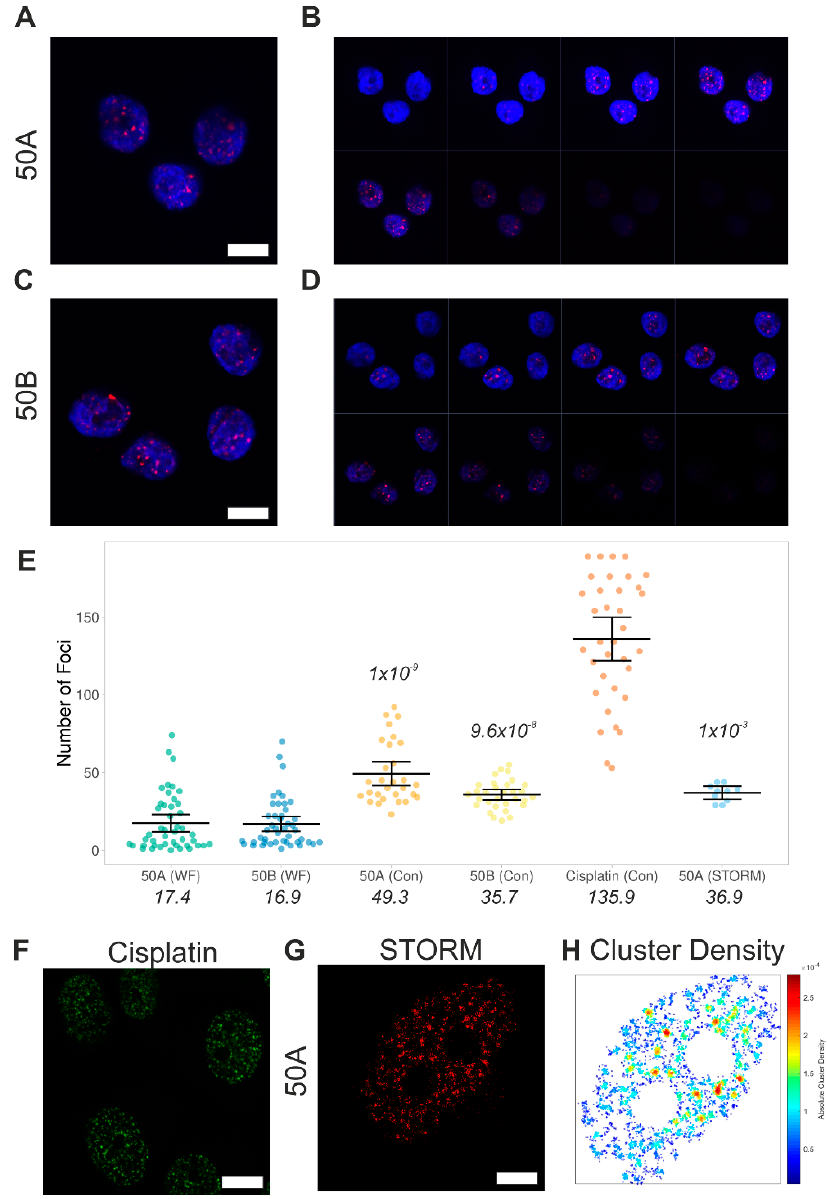
Figure 4. Impact of imaging methods upon the quantification of γ H2AX foci. ( A , B ) Confocal image and nuclear z -stack at 500 nm intervals of MCF10a cells stained for DNA with Hoechst (blue) and γ H2AX (red), 2 h after electroporation with Cas9 and 50A guide (GC-selective). Scale bar: 10 µ m. ( C , D ) The equivalent measurement with AT-selective 50B guide. Scale bar: 10 µ m. ( E ) Quantitative image analysis to determine the number of foci per nucleus. ‘WF’ refers to standard widefield imaging, as shown in Figure 2. ‘Con’ denotes confocal imaging, as shown in ( A – D ). ‘STORM’ refers to the number of foci determined by super resolution imaging and cluster analysis in panels ( F , G ). A comparison is shown for MCF10a cells treated with 25 µ M cisplatin for 4 h. Each data point is an individual nucleus. The p -value is calculated from a two-tailed t -test comparing measurements to the standard widefield imaging and the error bars represent SD. The mean values are presented. ( F ) Confocal image of γ H2AX in MCF10a cells following treatment with 25 µ M cisplatin for 4 h. Scale bar: 10 µ m. ( G ) Example STORM render image of γ H2AX, 2 h after electroporation with Cas9 and 50A guide (GC-selective) (scale bar 2 µ m). ( H ) Cluster map from panel ( F ) depicting density of γ H2AX molecules per µ m 2 . Clusters are defined by detecting a minimum of 3 molecules within a search area corresponding to the STORM localisation precision. The search area then propagates and a group of molecules is considered to be a cluster if at least 10 molecules are